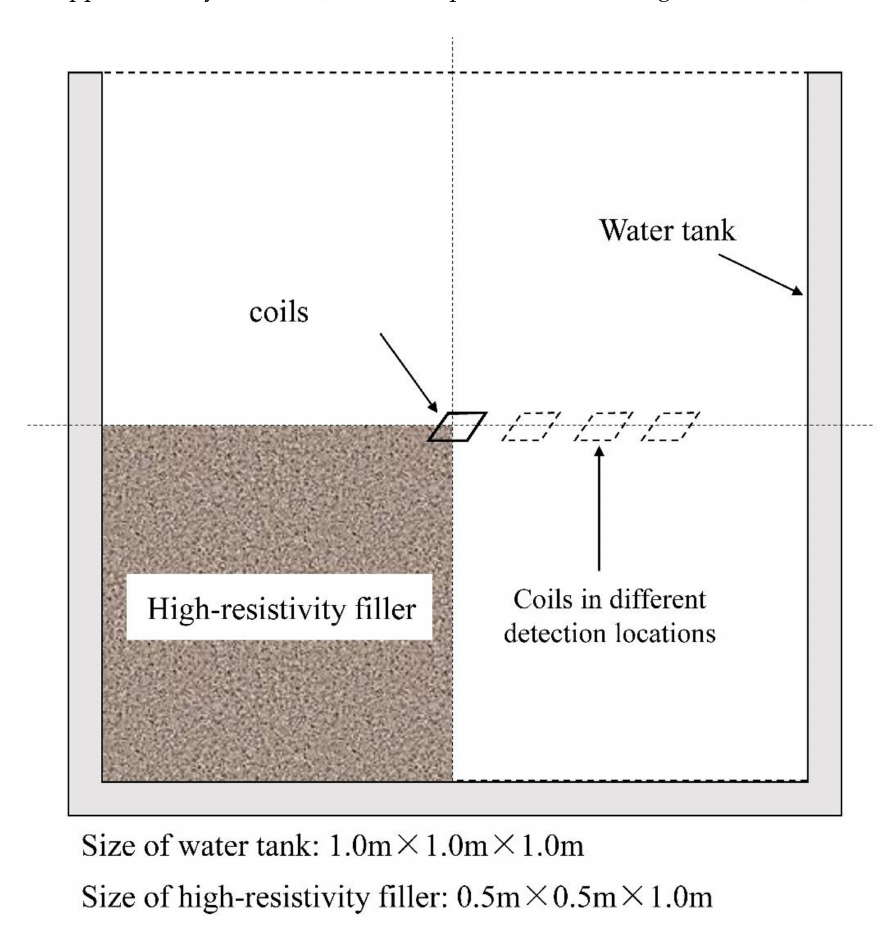
Figure 8. Schematic diagram of the vehicle-mounted transient electromagnetic spatial transforma- tion